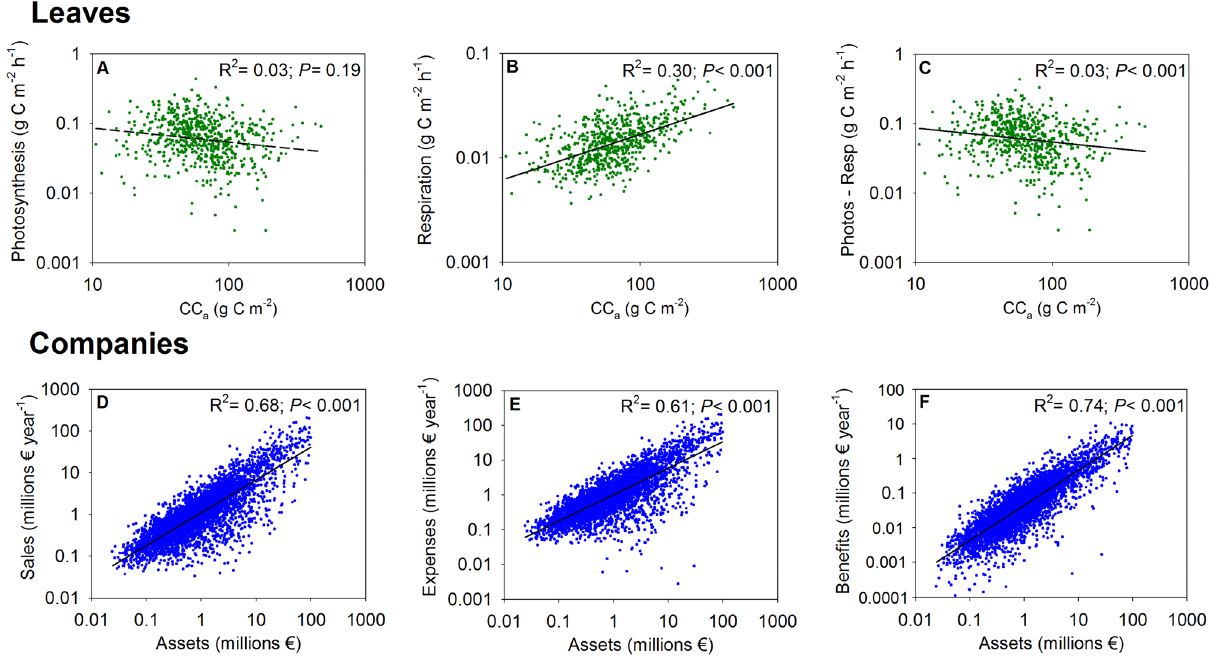
Figure 4. Relationships of ( A ) photosynthesis, ( B ) respiration and ( C ) benefits (photosynthesis-respiration) with construction cost per unit leaf area (CC a ) for leaves. Relationships of ( D ) sales, ( E ) expenses and ( F ) benefits with assets for